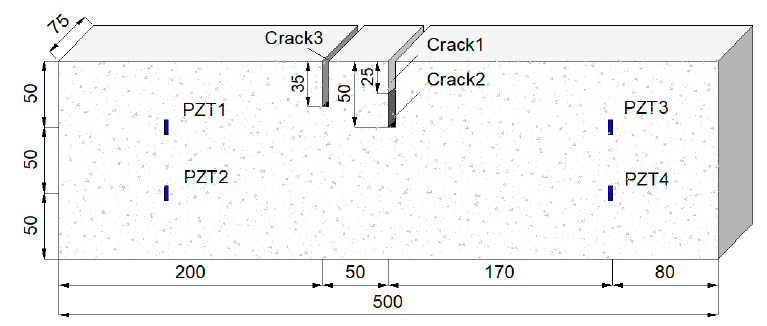
Figure 8. Layout of the cracks and sensor array.